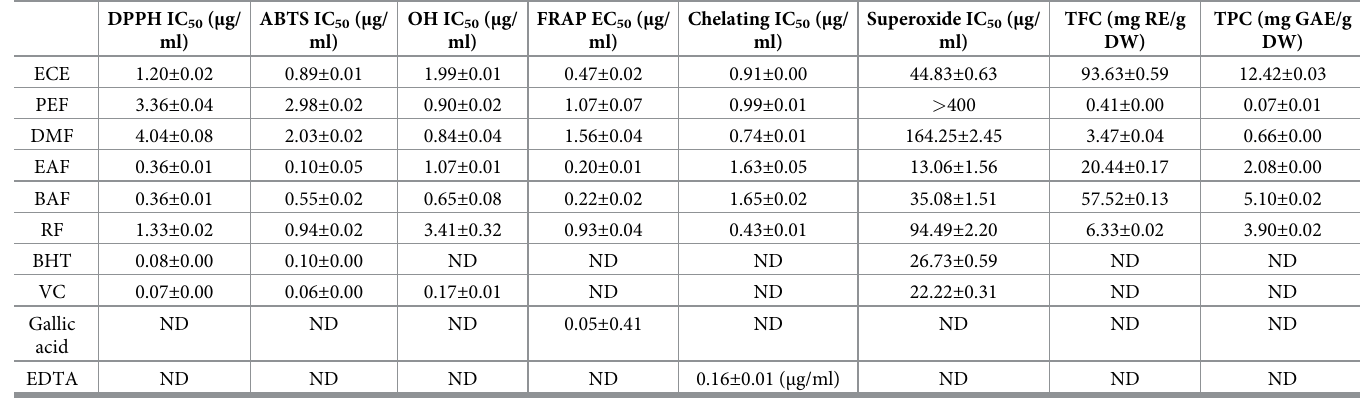
Table 1. Antioxidant activities and contents of total phenolics and total flavonoids of the ethanolic extracts and subfractions from C . cyrtophyllum . DPPH IC 50 ( μ g/